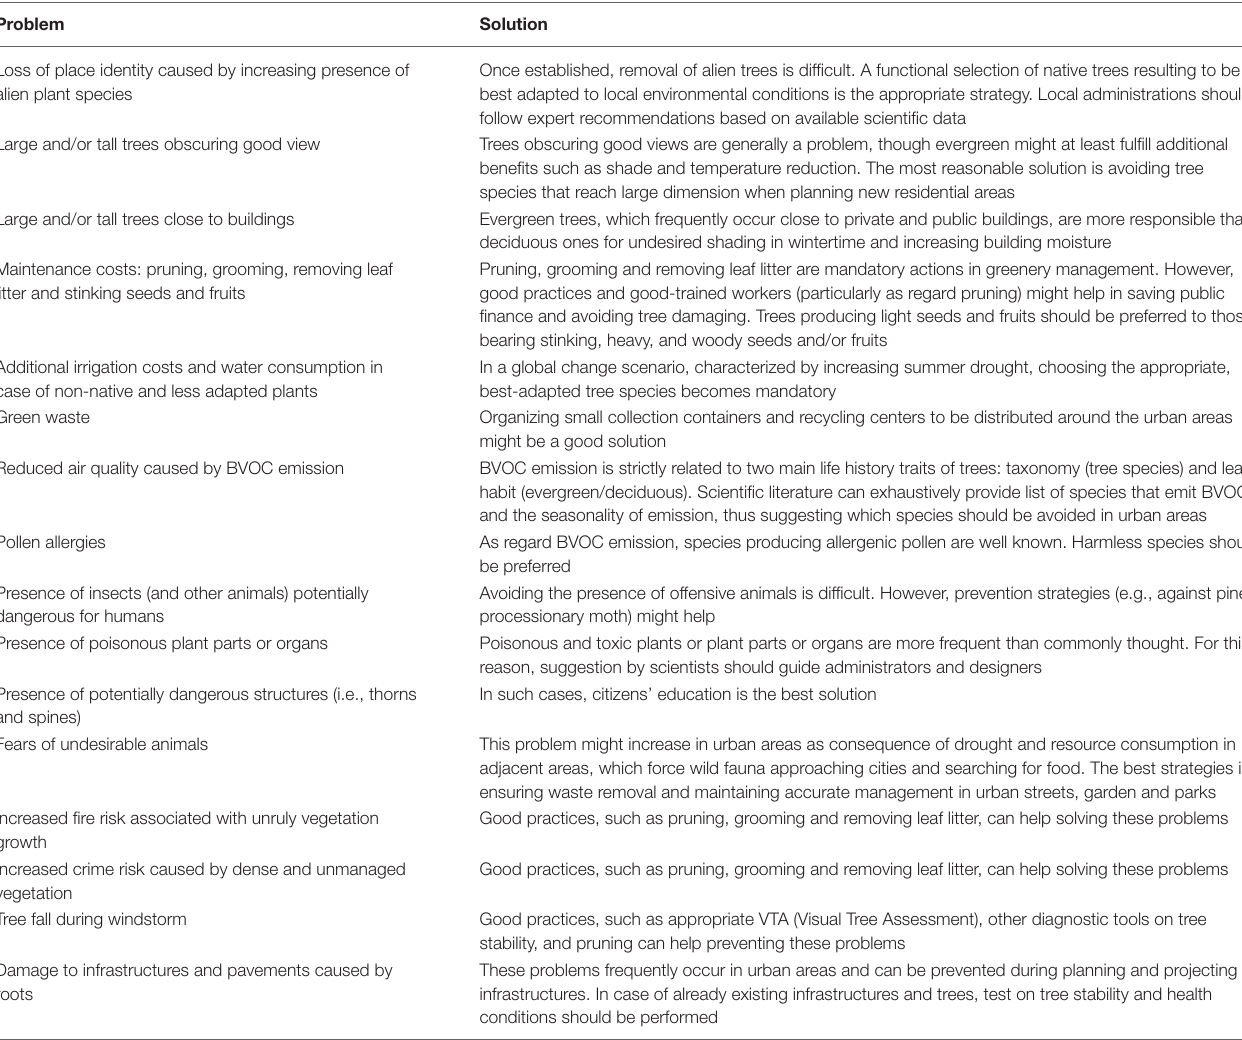
TABLE 2 | Main problems possibly caused by plants in urban areas and perspective solutions. Problem